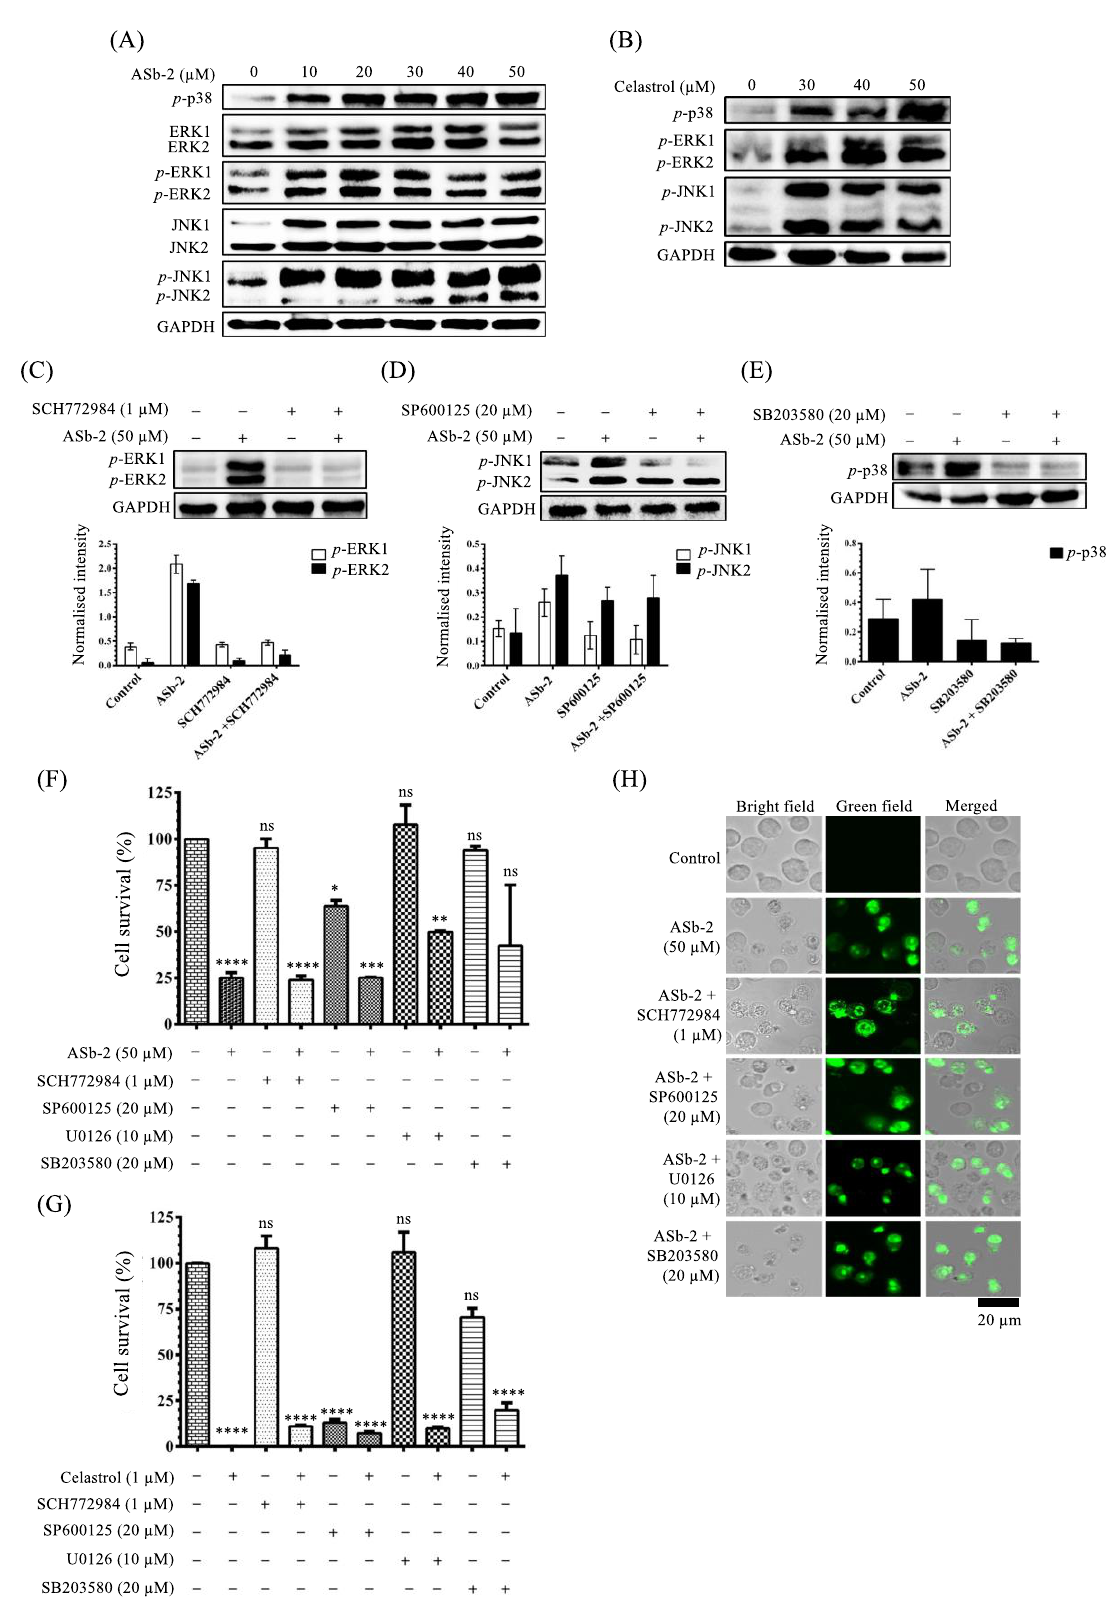
Figure 12. ( A ) Western blot analyses of the MAPK signaling pathway in the presence of ASb-2 in Jurkat cells for 1 h at 37 °C. (B ) Western blot analyses of the MAPK signaling pathway in the presence of celastrol in Jurkat cells for 1 h at 37 °C. ( C) The results for the p -ERK1/2 expression in Jurkat cells treated with ASb-2 in the presence of SCH772984 for 1 h at 37 °C. ( D ) The results of p -JNK1/2 expression of Jurkat cells treated with ASb-2 in the presence of SP600125 for 1 h at 37 °C.